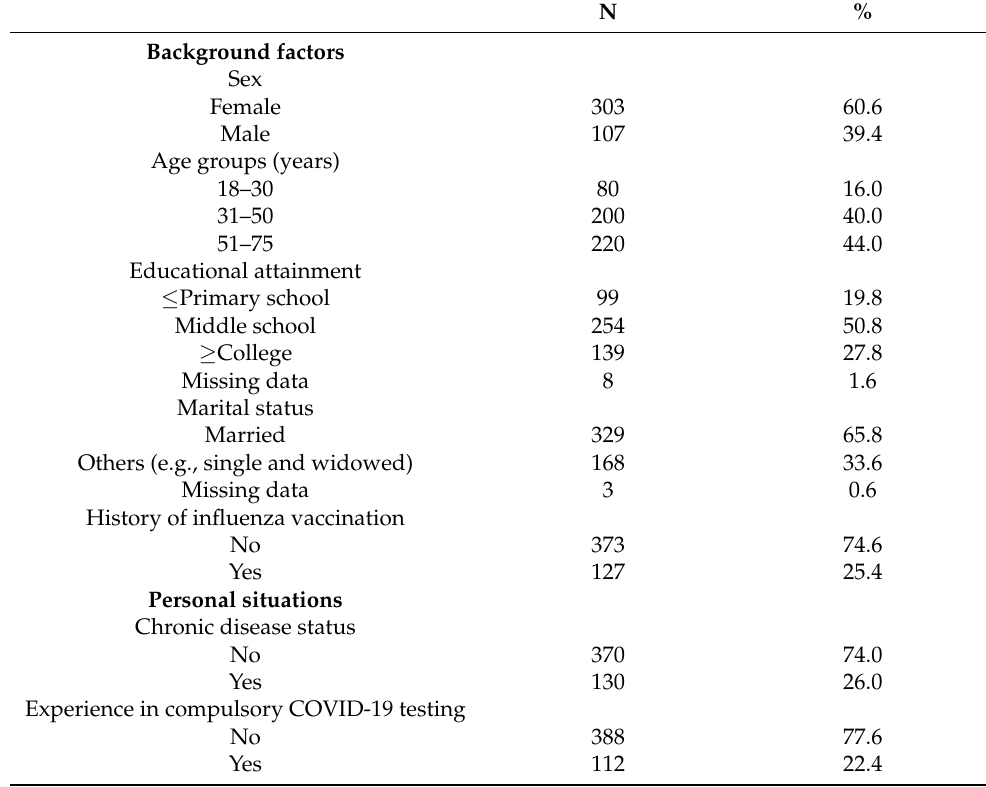
Table 1. Descriptive statistics of the categorical background and independent variables ( n = 500).